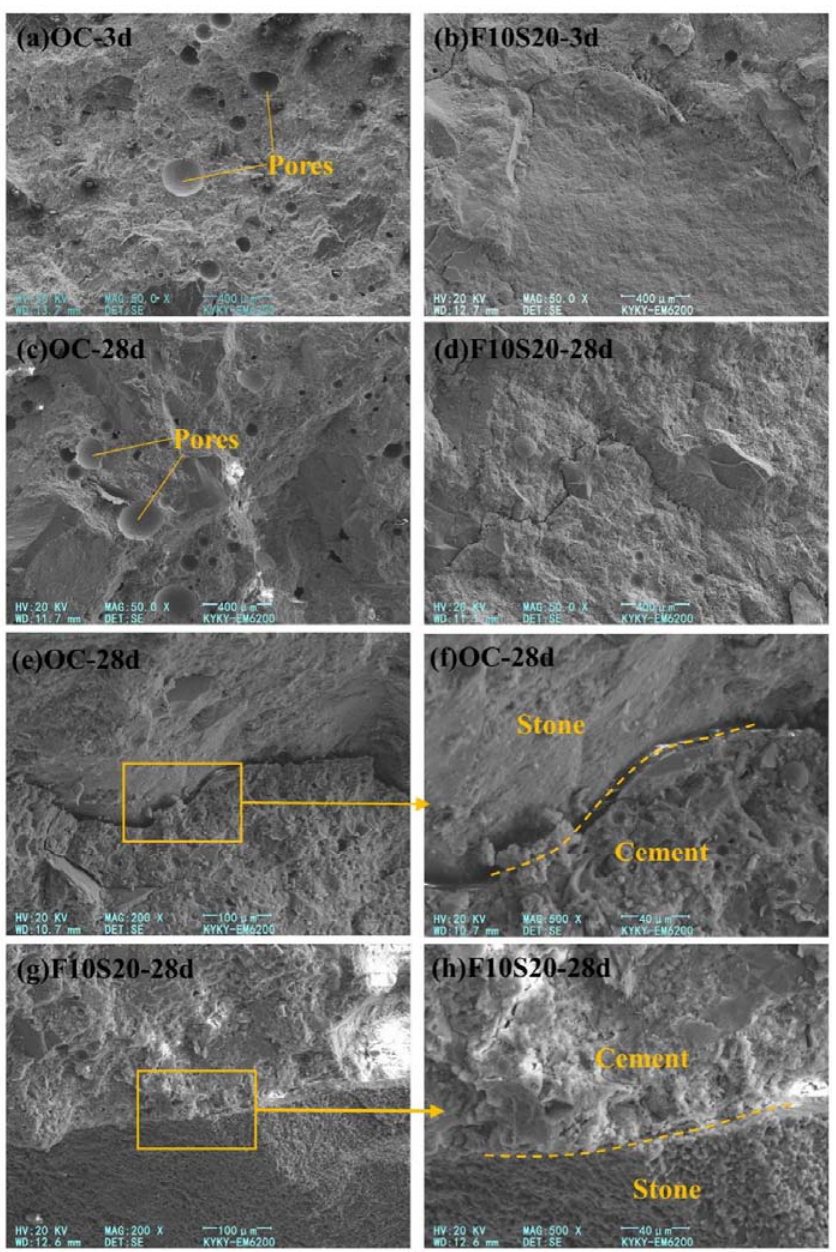
Figure 9. SEM images of OC and F10S20 concrete: ( a ) Microstructure of OC concrete at 3 d; ( b ) Microstructure of F10S20 concrete at 3 d; ( c ) Microstructure of OC concrete at 28 d; ( d ) Mi- crostructure of F10S20 concrete at 28 d; ( e ) ITZ of OC concrete at 28 d; ( f ) Magnified ITZ of OC concrete at 28 d; ( g ) ITZ of F10S20 concrete at 28 d; ( h ) Magnified ITZ of F10S20 concrete at 28